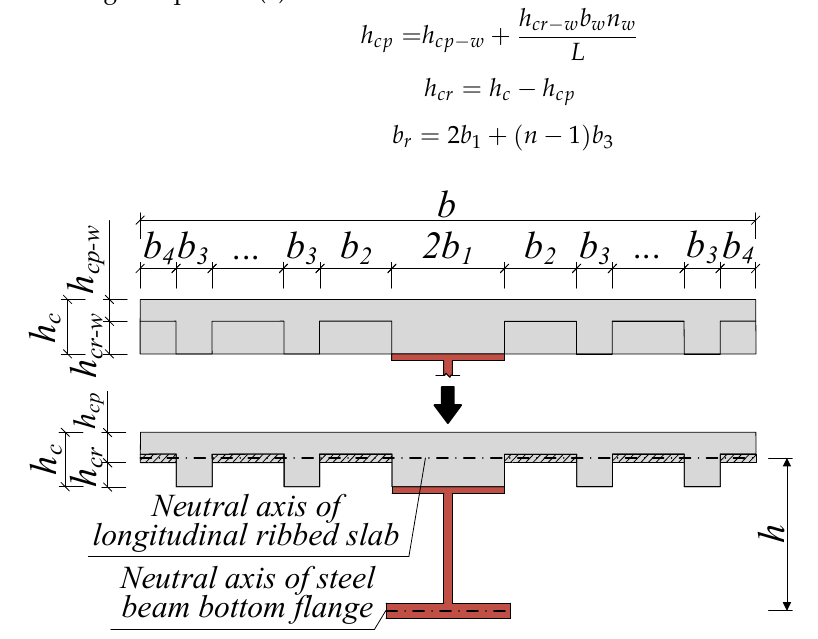
Neutral axis of longitudinal ribbed slab h Neutral axis of steel beam bottom flange Figure 3. Volume equivalent model. The bar simulation method considers the objective structure as an ideal combination of stiffeners and equivalent thin plates, where the equivalent thin plates only transmit shear force, and the longitudinal stiffeners only transmit axial force [24]. SU-WSCS can be